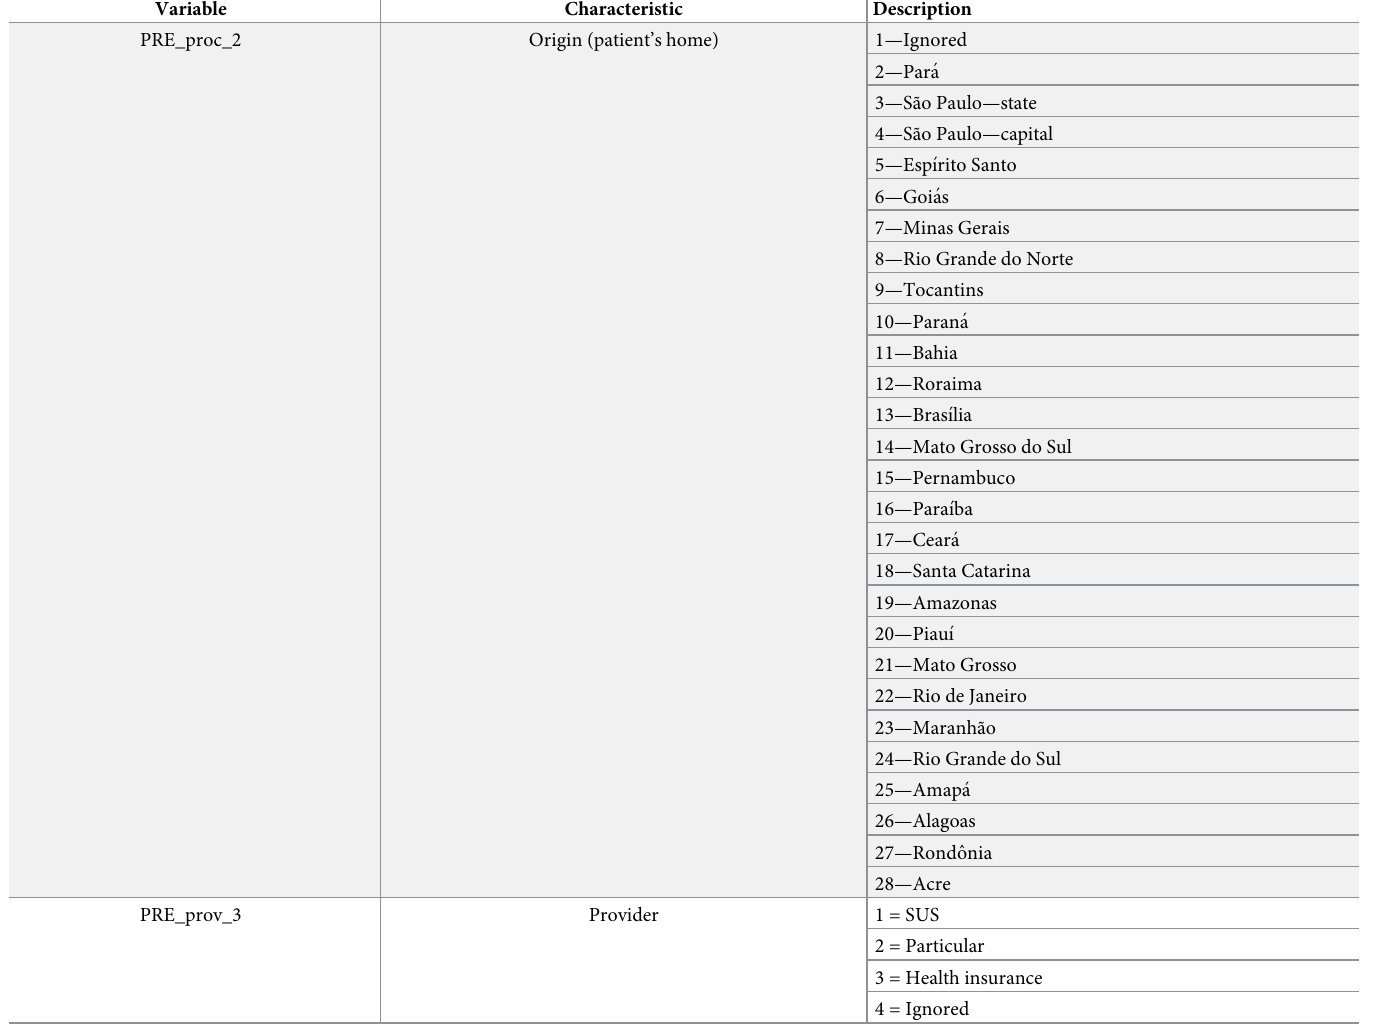
Table 1. Pre-operative variables.